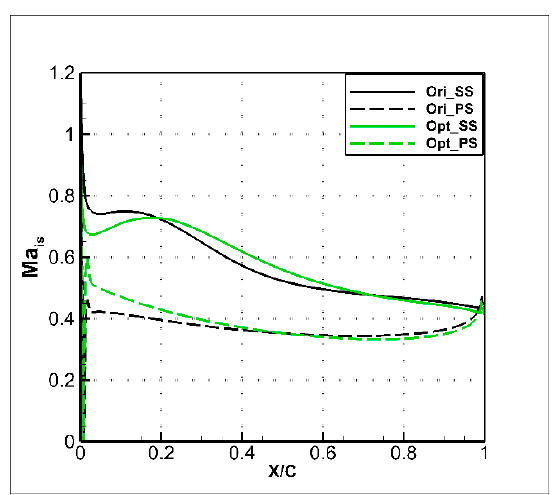
Figure 21. Isentropic Mach number on 95% of the span height of second-stage stator for original and optimized compressor.